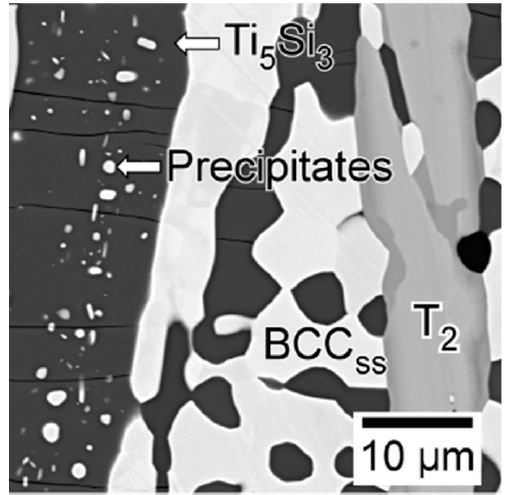
Figure 9. Microstructure of Mo–50Ti–14Si–6C–6B (at.%) alloy annealed at 1500 °C for 24 h [53]. Hatakeyama et al. [53] analyzed the orientation relationship between BCC precipitates and the D8 8 matrix of the Mo–50Ti–14Si–6C–6B (at.%) alloy (see Figure 10). They found that the faceted interfaces between BCC and D8 8 meet an edge-to-edge [54] matching that produces low energy and are stochastically favored during solid-state precipitation. Thanks to these thermally stabilized BCC precipitates and their low-energy interfaces, the toughness of these alloys may be improved by the crack bridging or crack deflection mechanisms if the size and distribution of the precipitates are carefully tailored through an appropriate annealing